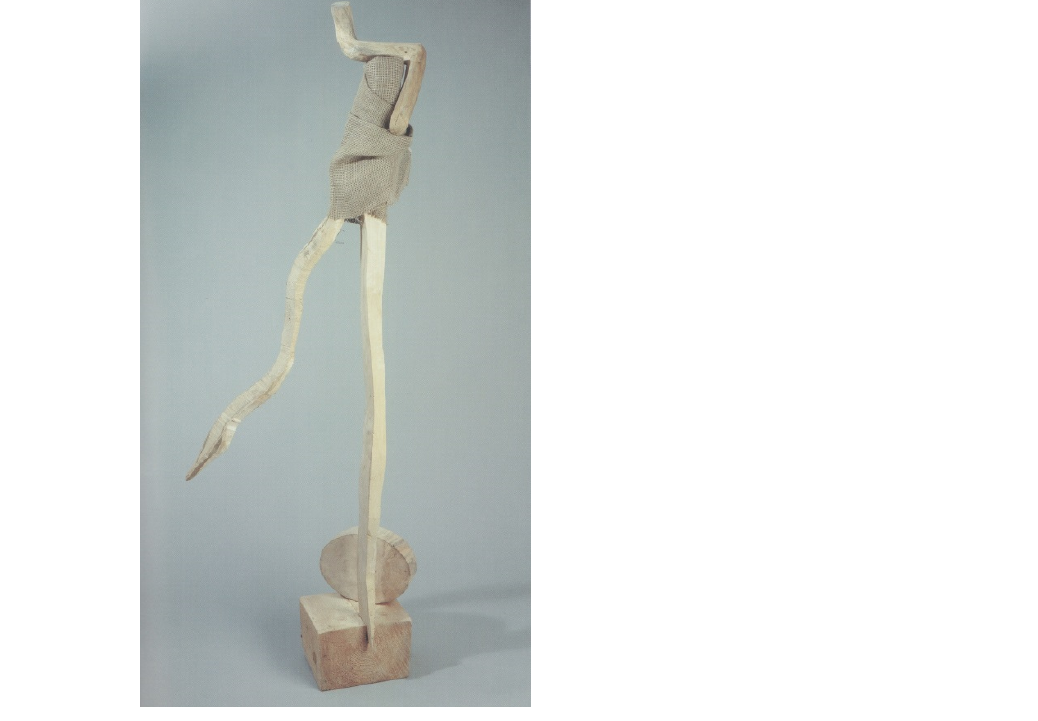
Figure 7. Leon Podsiadły, Za progiem ― radość [ Behind the Threshold ― Joy ] 2012, wood, fabric. Photograph by Stanisław Sielicki. After: (Wąs 2012a, p. 25). Photo used with the permission of the artist’s family.